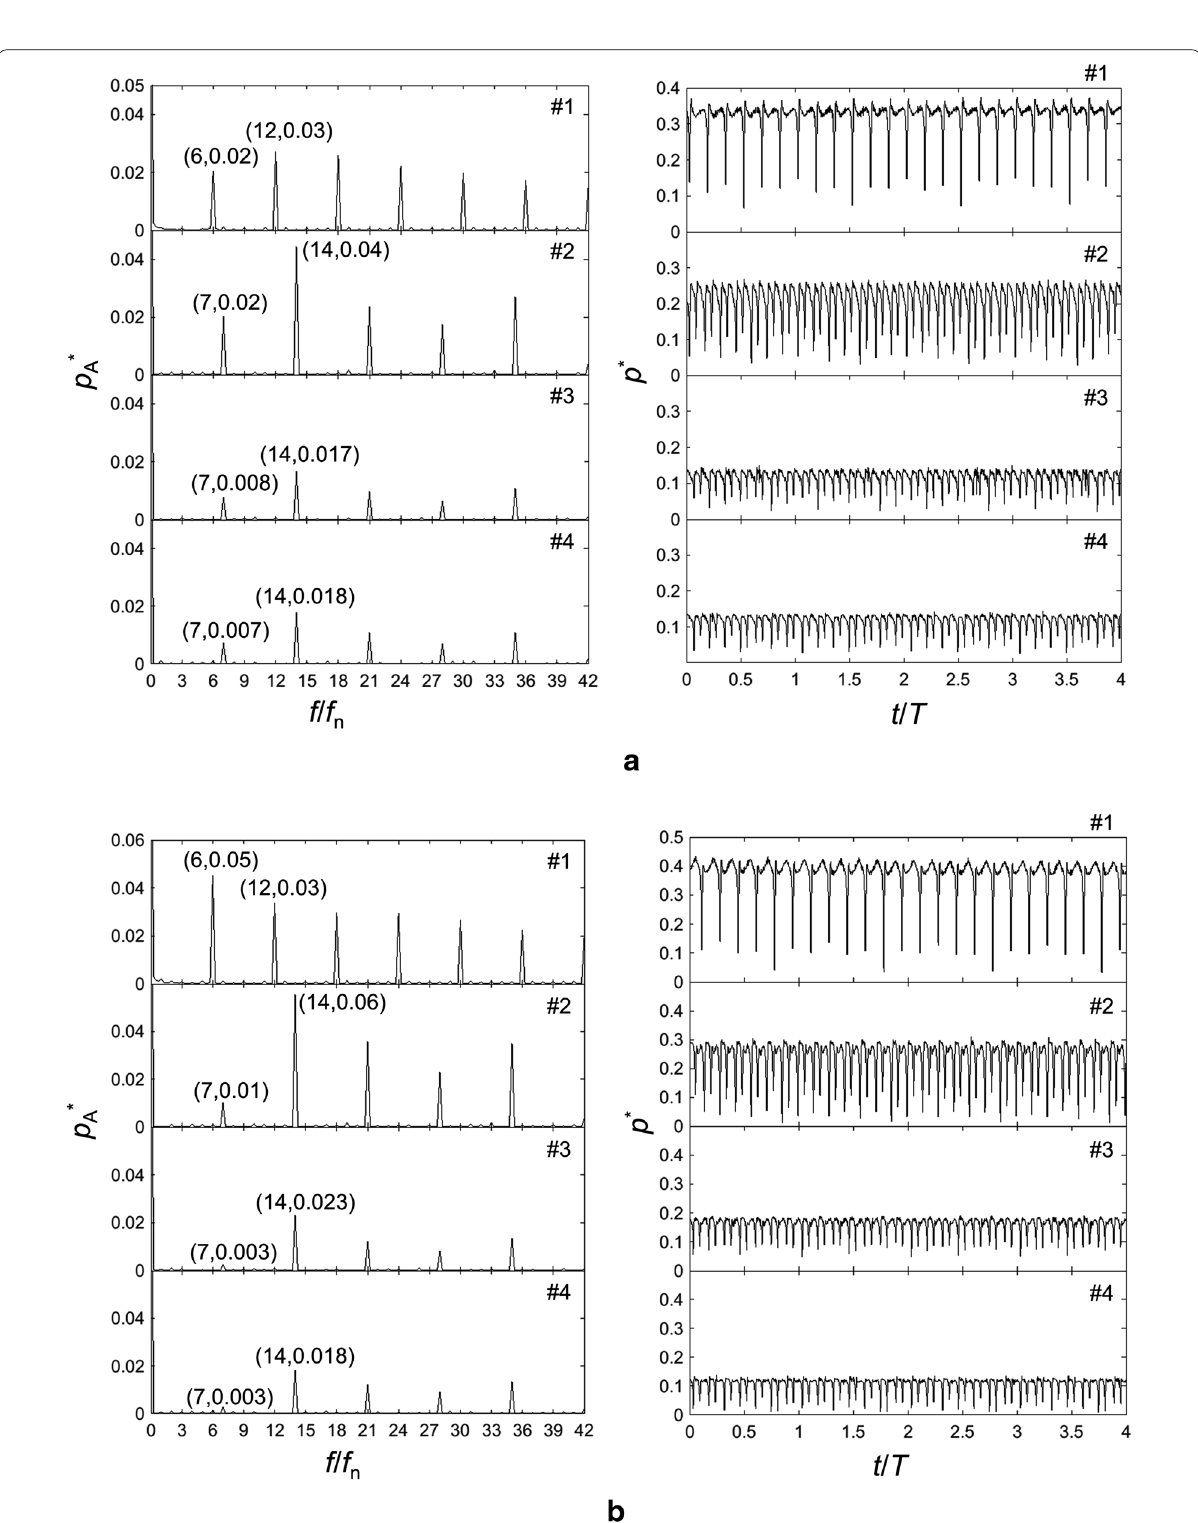
Figure 9 Frequency and time domains of the pressure fluctuation in the impeller: a on monitoring point P1; b on monitoring point P3; c on monitoring point P5; d on monitoring point